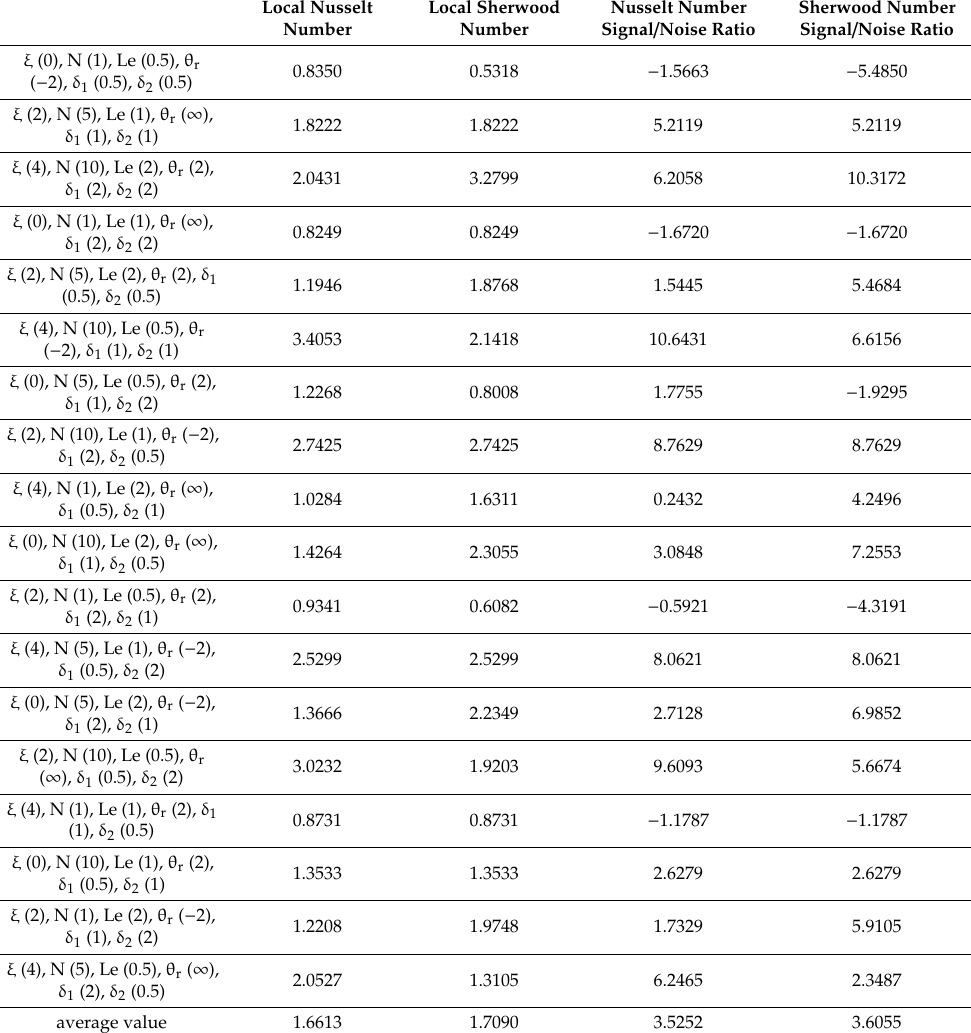
Table 4. The orthogonal table values of the local Nusselt number, the local Sherwood number, the local Nusselt number signal / noise ratio and the local Sherwood number signal / noise